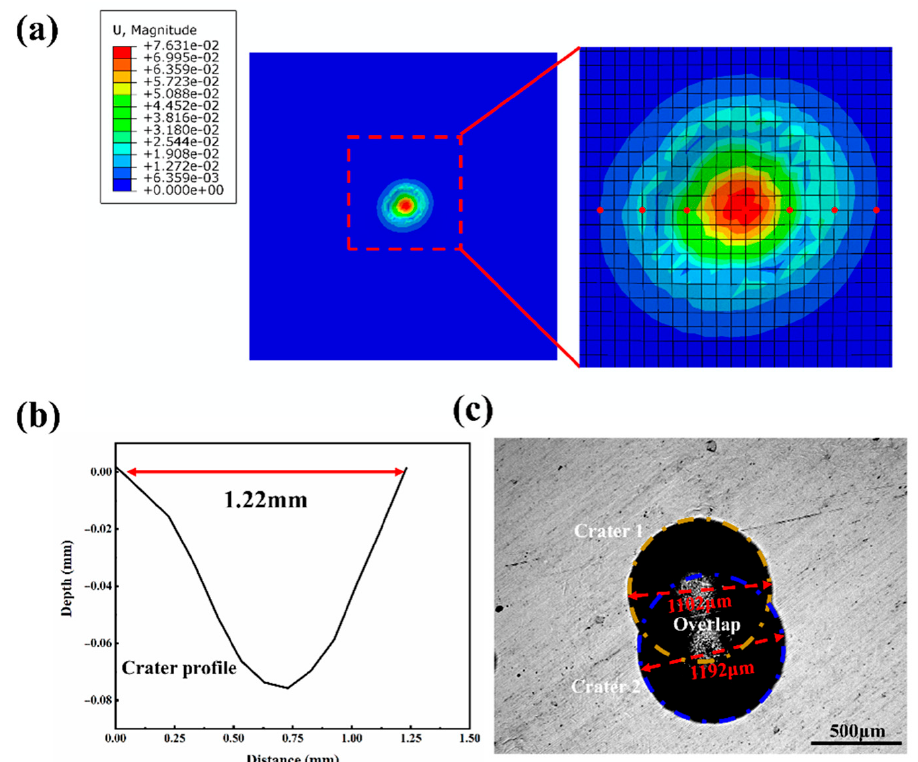
Figure 8. Experimental verification of the established finite element simulation model: ( a ) The displacement of the peened surface with the simulation period of 0.01 s; ( b ) the profile of a crater on the peened surface; ( c ) optical microscopy observation of the craters on the ultrasonic shot peened 316L stainless steel surface.